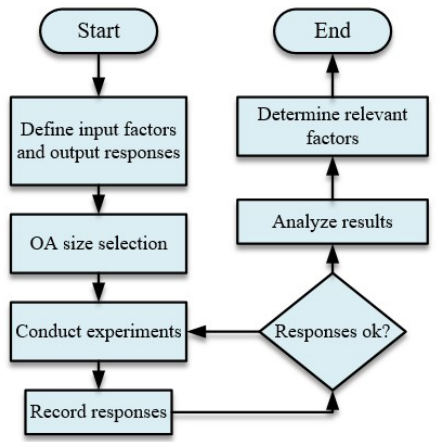
Figure 6. Design procedure for determining the impact of pulse current factors on LiPo battery.